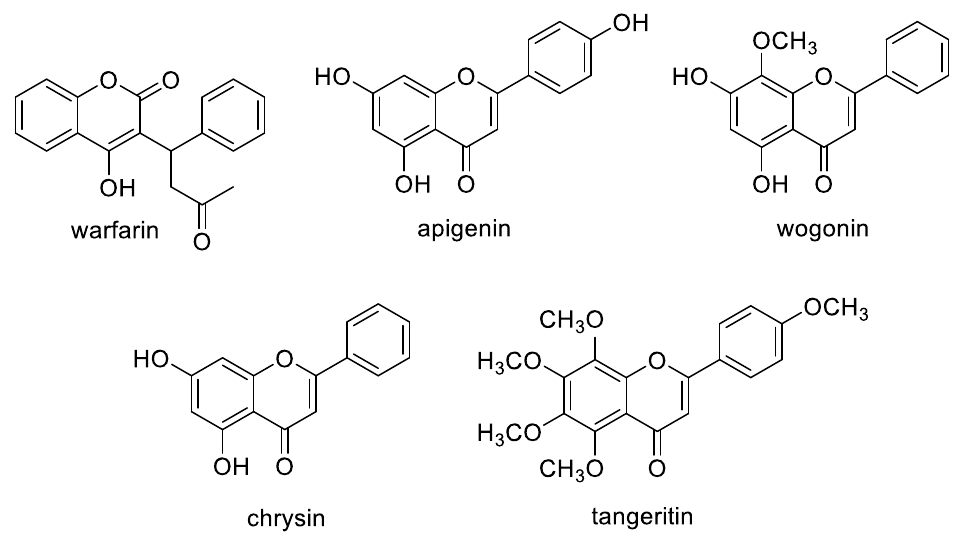
Figure 6. Chemical structure of some flavones.